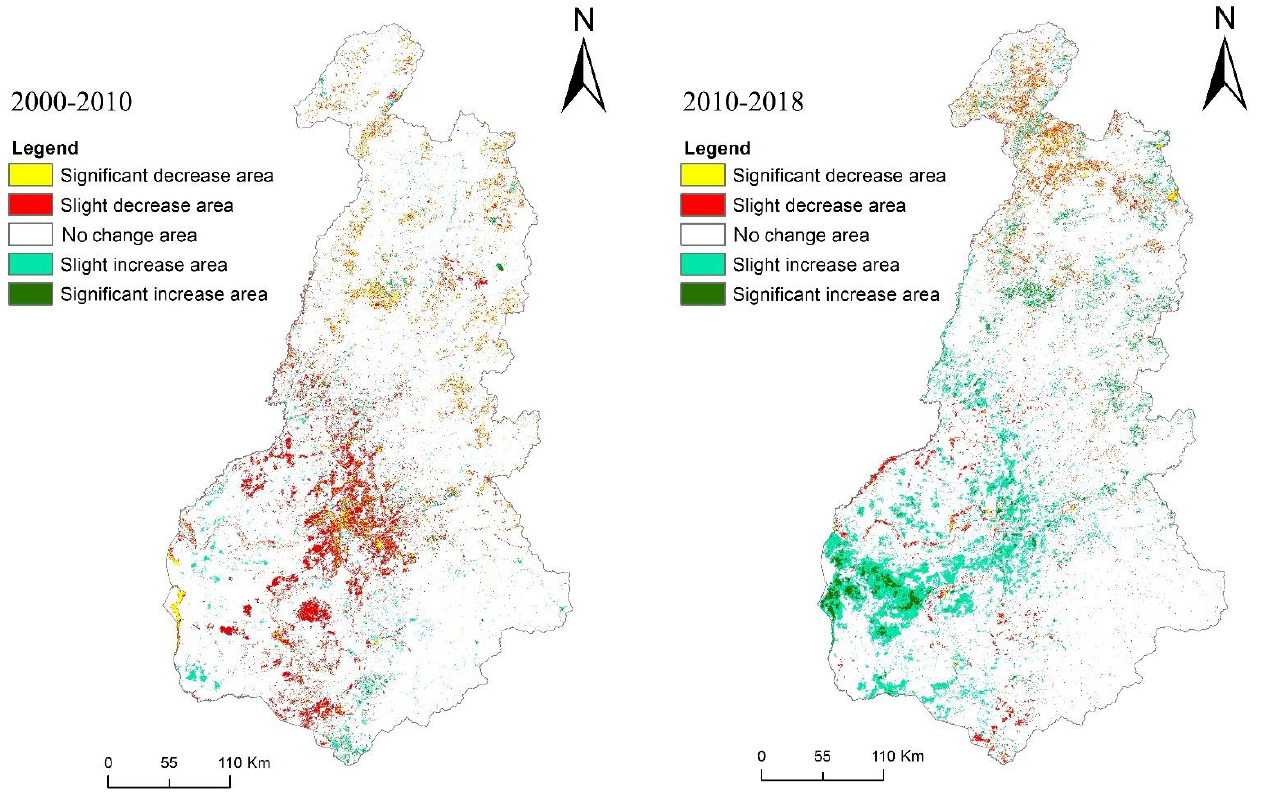
Figure 10. FVC change in the forest-steppe ecotone from 2000 to 2010 ( left ) and from 2010 to 2018 ( right ).